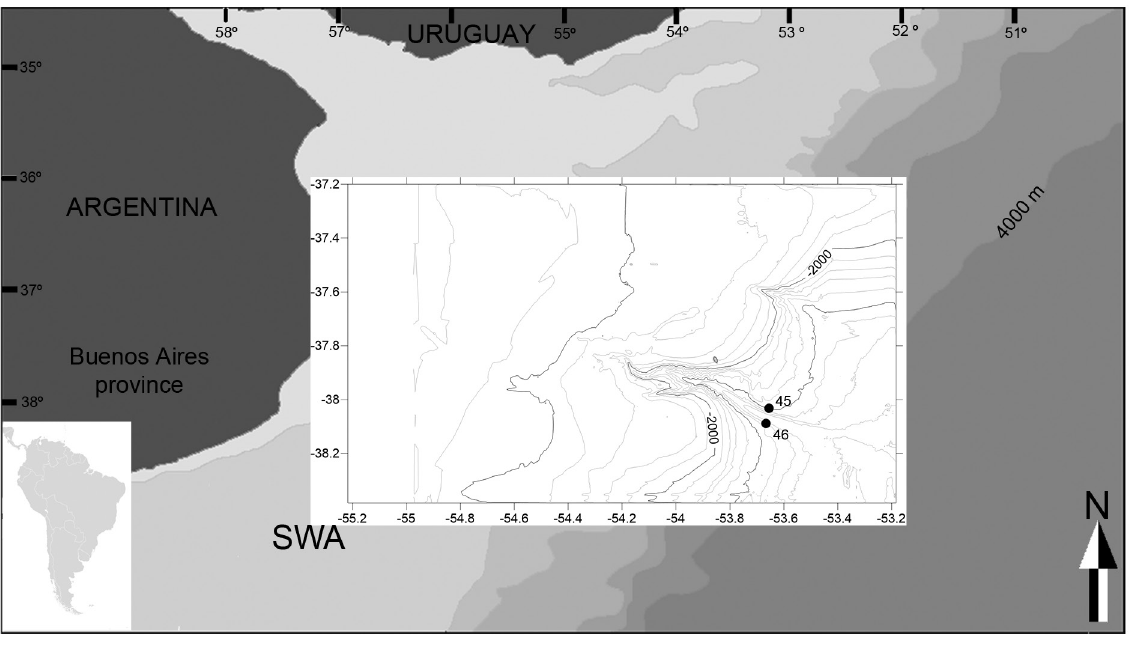
Fig. 1. Distribution of Umbellula pomona Risaro, Williams & Lauretta sp. nov. in Mar del Plata Submarine